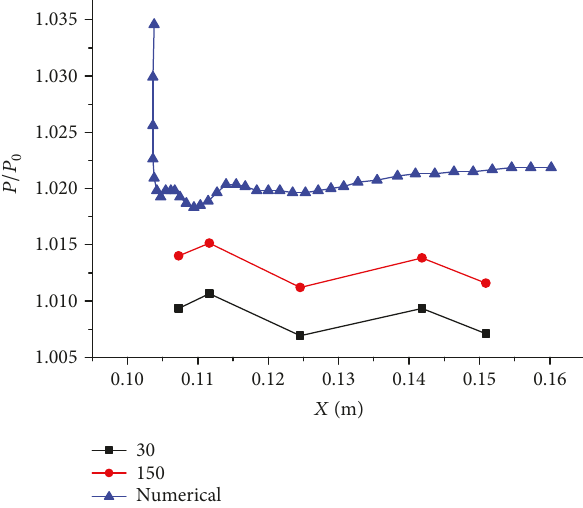
Figure 12: Comparison of predicted and measured velocity in dump di ff user.